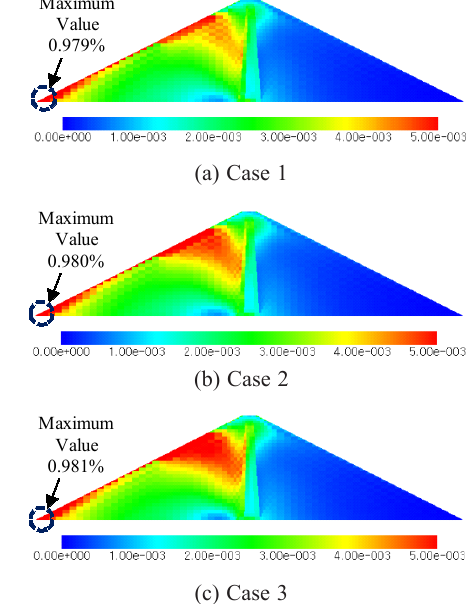
Fig. 14. Distribution of p γ at the end of the numerical simulation on each